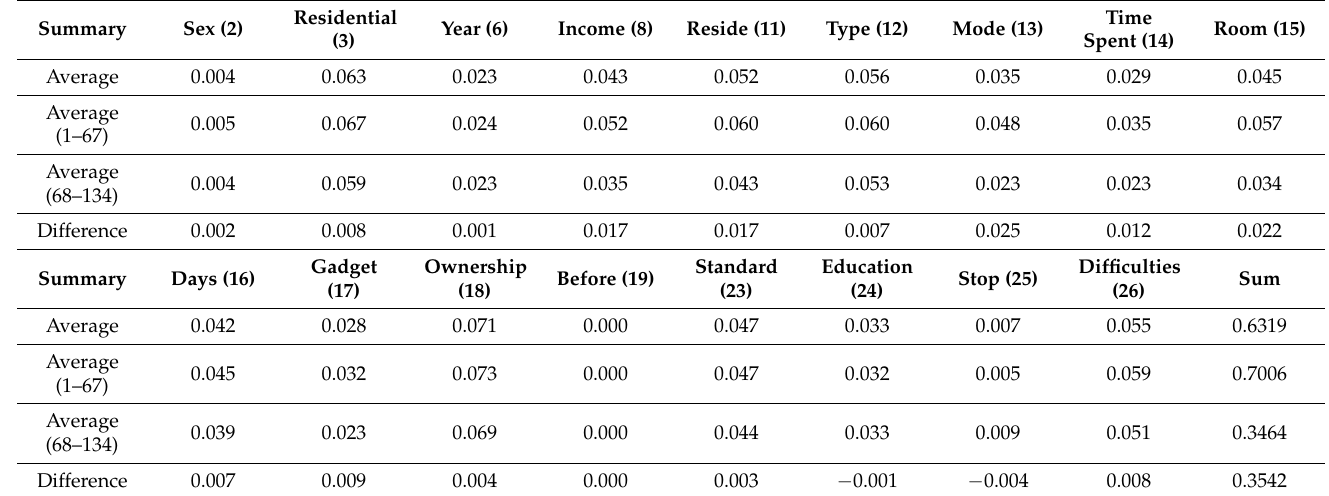
Table 11. Comparison between students’ groups by attributes